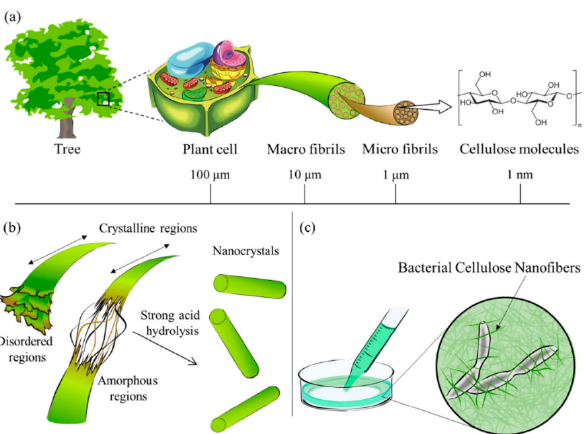
Figure 4. ( a ) Cellulose contained in plants or trees has a hierarchical structure from the meter to the nanometer scale, ( b ) schematic diagram of the reaction between cellulose and strong acid to obtain nanocellulose, ( c ) bionanocellulose cultured from cellulose-synthesizing bacteria. Reprinted from [56] .